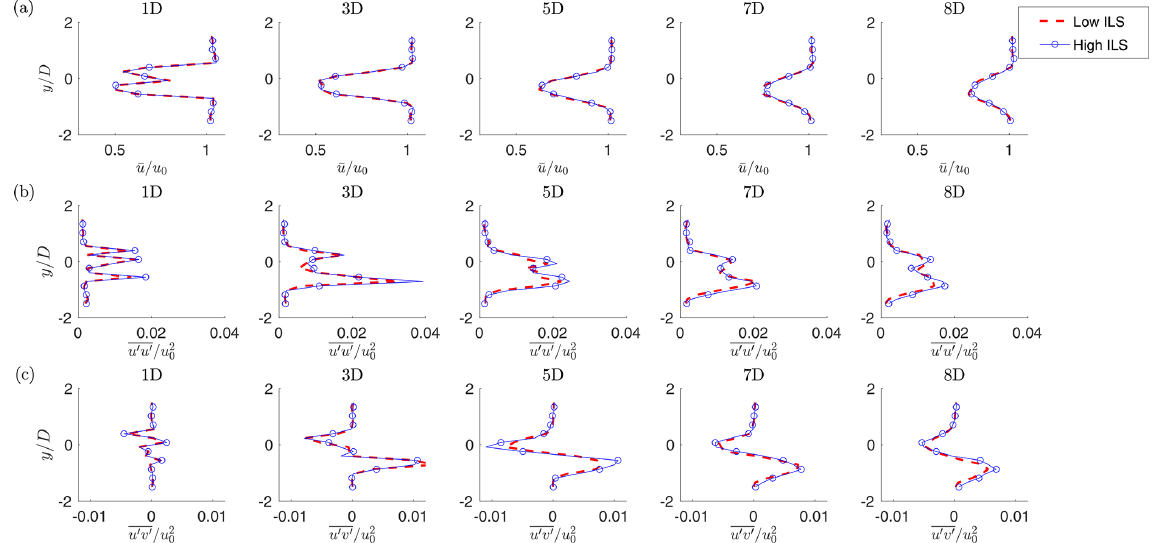
Figure 18. Hub-height profiles of normalized time-average streamwise velocity (a) and shear stresses (b, c) , for the low- and high-ILS cases in yaw misaligned